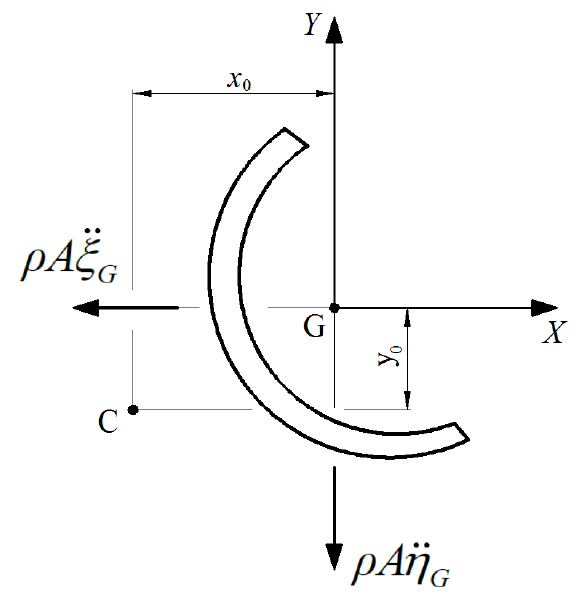
Figure 8: Scheme of the j-th floor of a tall building subjected to inertial